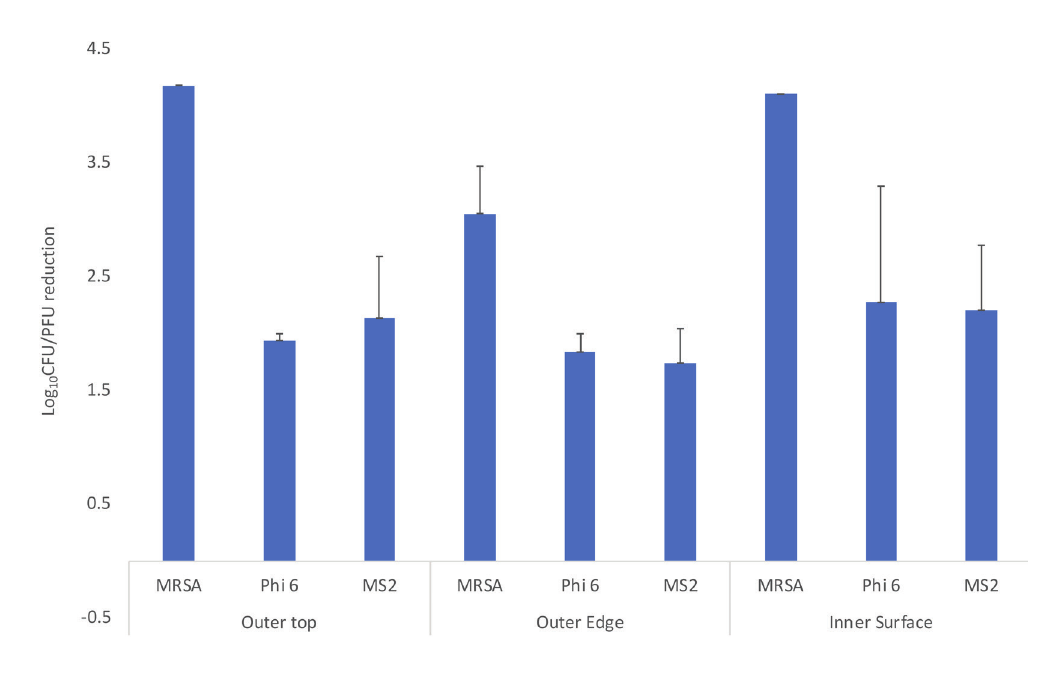
Figure 3. Efficacy of ultraviolet (UV) light delivered by low-pressure mercury decontamination device for decontamination of methicillin-resistant Staphylococcus aureus (MRSA), bacteriophage MS2, and bacte- riophage Phi6 on Moldex 1517 N95 respirators. 10-μL aliquots containing 10 6 colony-forming units (CFU) or plaque-forming units (PFU) of the test organisms in the simulated mucous suspension were spread to cover an area of 1-cm2 on 3 different areas on the respirator surface (top exterior, edge exterior, and inte- rior) as shown in Figure 1. The respirator was exposed to a 15-minute cycle of UV at 3 feet from the bulbs then turned for another 15-minute cycle on the opposite side. Error bars indicate standard